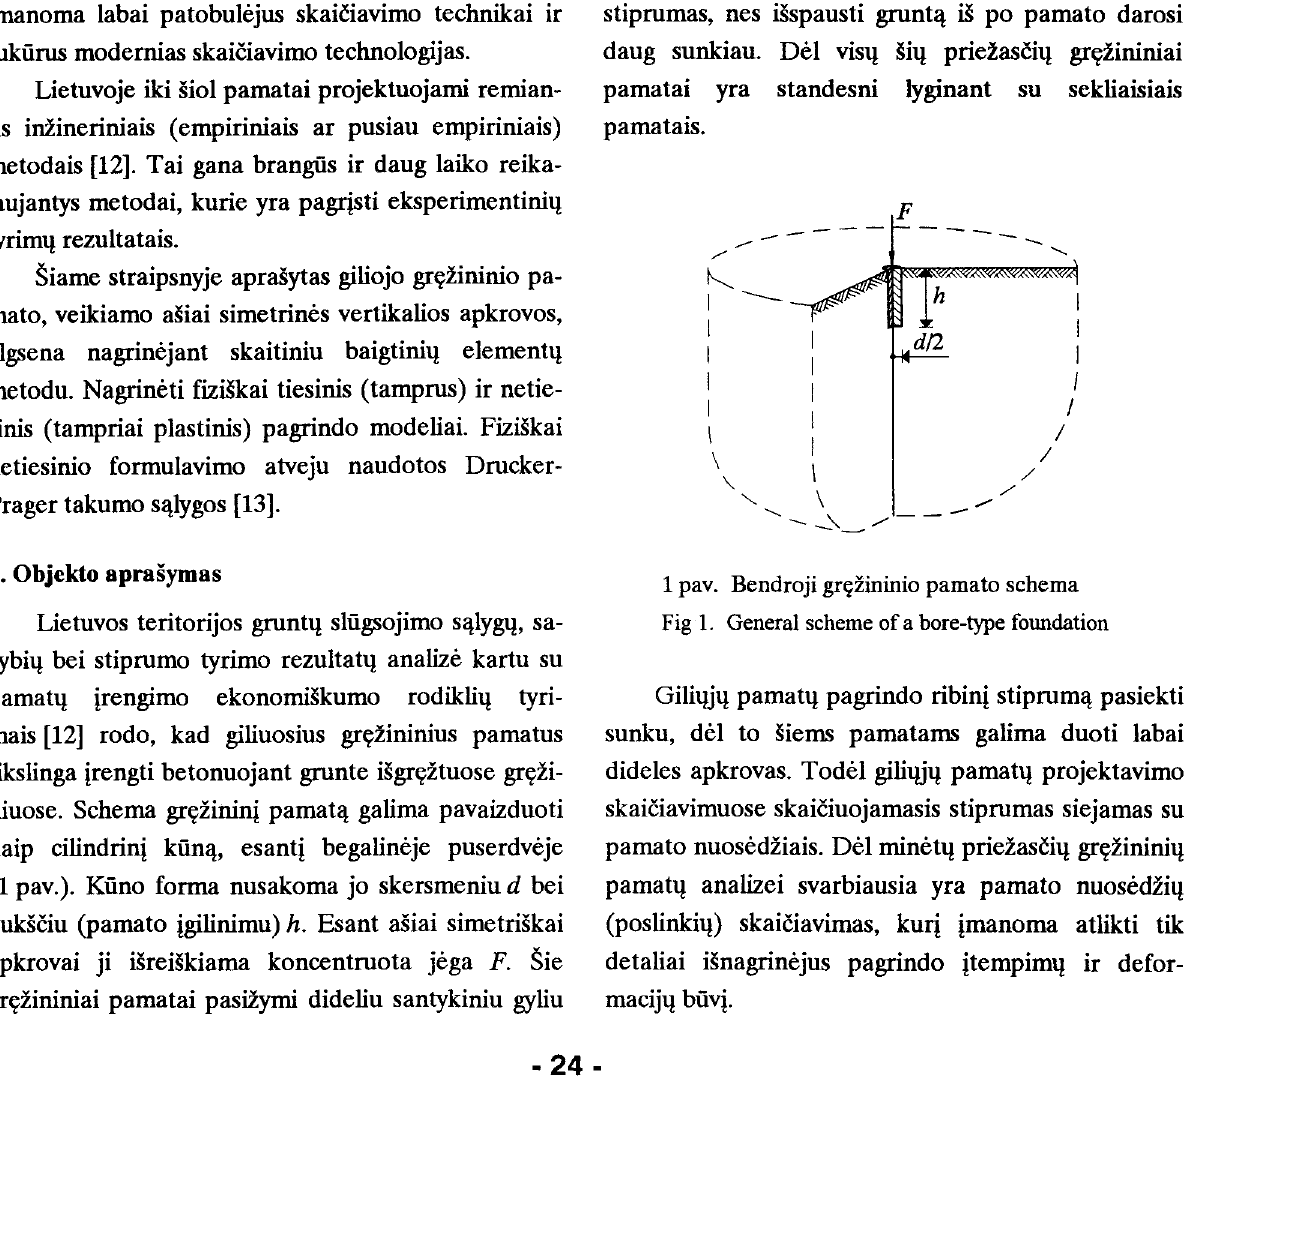
Fig 1. General scheme of a bore-type fotmdation